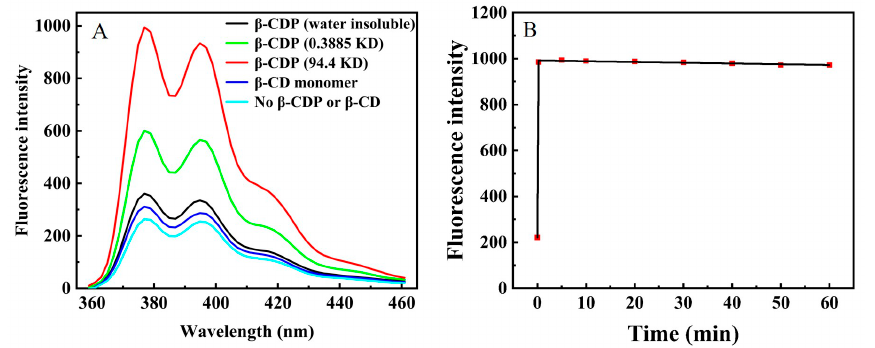
Figure 2. ( A ) Fluorescence emission spectra in addition to β -CDP or β -CD monomer. ( B ) Fluores- cence intensity of pyrene in addition to β -CDP vs. time. The concentration of β -CDP was 1.5 mg/mL. The concentration of pyrene labeled aptamer was 400 nM. The maximum emission wavelength was set at 376 nm.